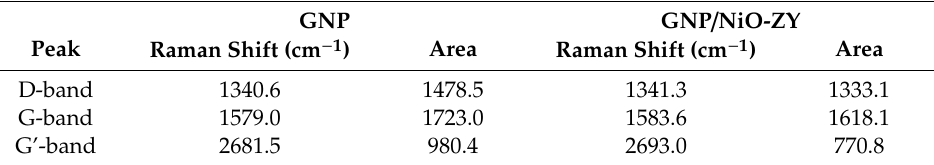
Table 3. Peak frequencies and areas of the various Raman bands for GNP and GNP / NiO-ZY. GNP GNP /